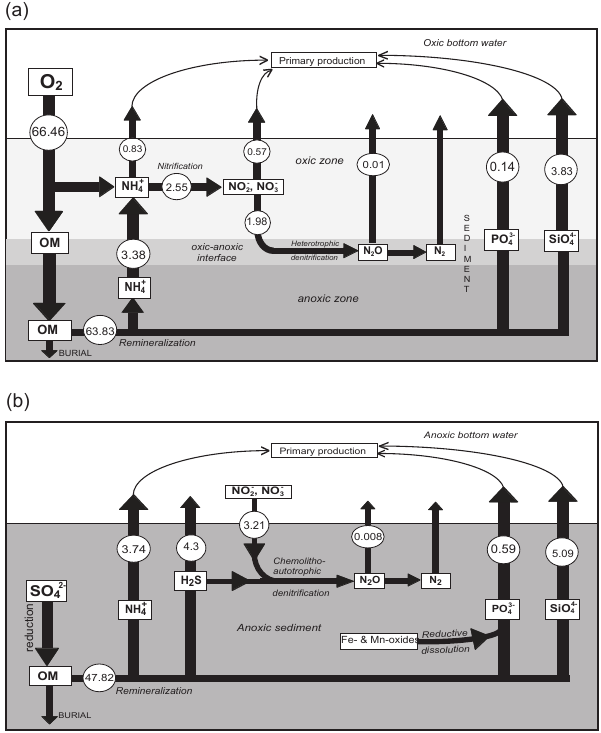
Figure 5. (a) Schematic diagram of sediment oxygen consump- tion (SOC), organic matter (OM) mineralization and nutrient fluxes during April, based on the results of experiments 4, 5 and 6. (b) Schematic diagram of organic matter (OM) mineralization and nu- trient fluxes during October, based on the results of experiments 1, 2 and 3. Numbers inside the circles are flux rates in mmolm − 2 d − 1 .